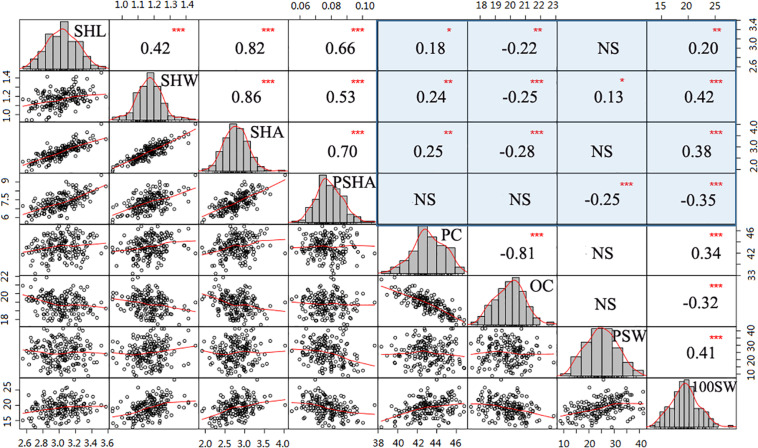
Correlation analysis among hilum, quality, and yield traits. Histograms with fitting curves of traits are graphed in the diagonal. Above the diagonal are correlation coefficients with significant levels. Below the diagonal are scatter plots with fitting curves. Red asterisks indicate significant correlations at the *P = 0.05, **P = 0.011, and ***P = 0.001 levels.